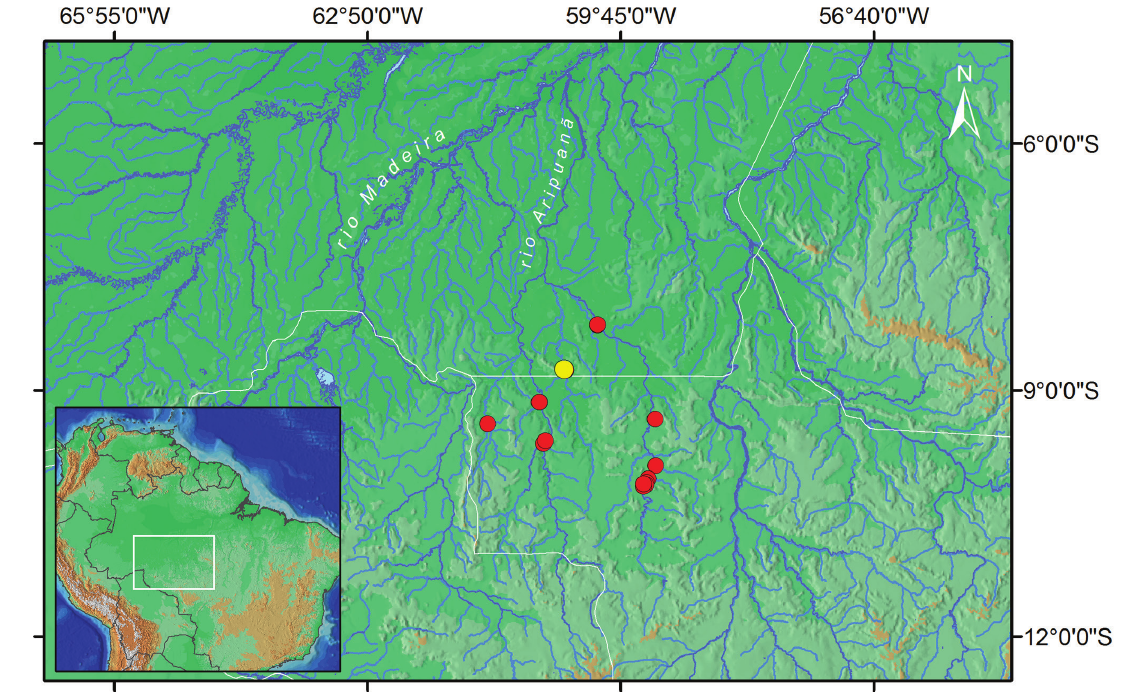
Fig. 4. Distribution of Aphanotorulus rubrocauda in the rio Aripuanã basin. Type locality is represented by the yellow circle. Some symbols represent more than one lot or